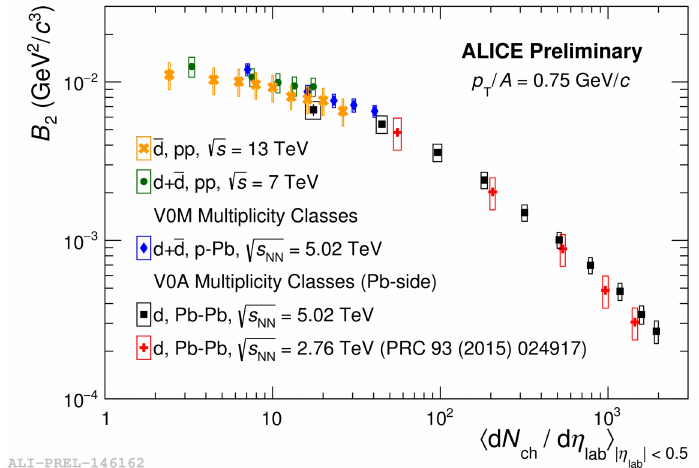
Figure 2. Coalescence parameter B 2 at p T / A = 0.75 GeV/ c as a function of multiplicity.